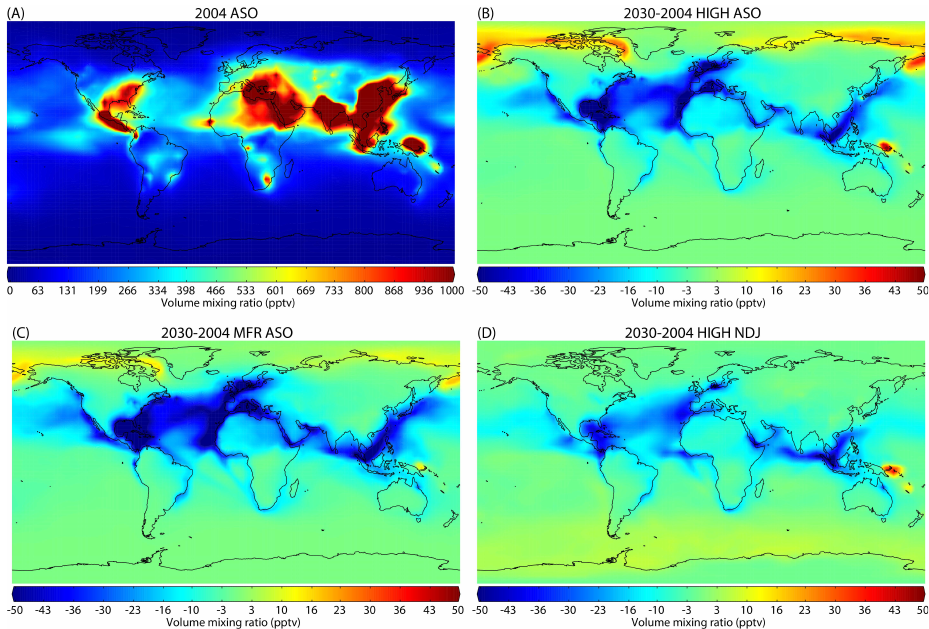
Fig. 3. Sulfate in the lowest model layer close to the surface (pptv). (A) Average 2004 for the months August-September-October (ASO). (B) Average change 2004–2030 HIGH scenario for the months ASO. (C) Same as (B) , MFR scenario (D) Same as (B) , HIGH scenario, months November-December-January